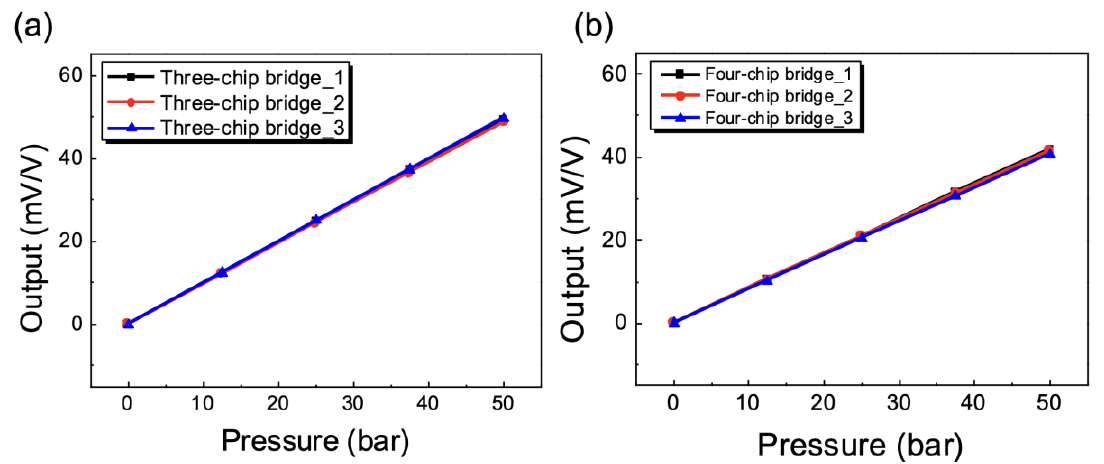
Figure 14. Output voltage vs. pressure curves of three- and four-full-bridge circuits: ( a ) three-chip bridges; ( b ) four-chip bridges.